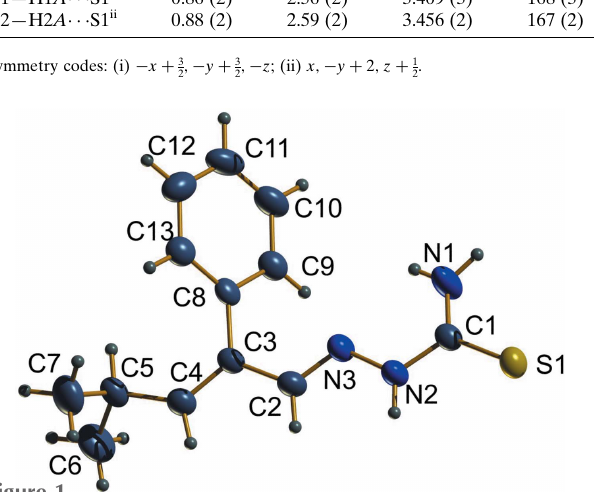
Figure 1 The molecular structure of the title compound with displacement ellipsoids drawn at the 50% probability level.